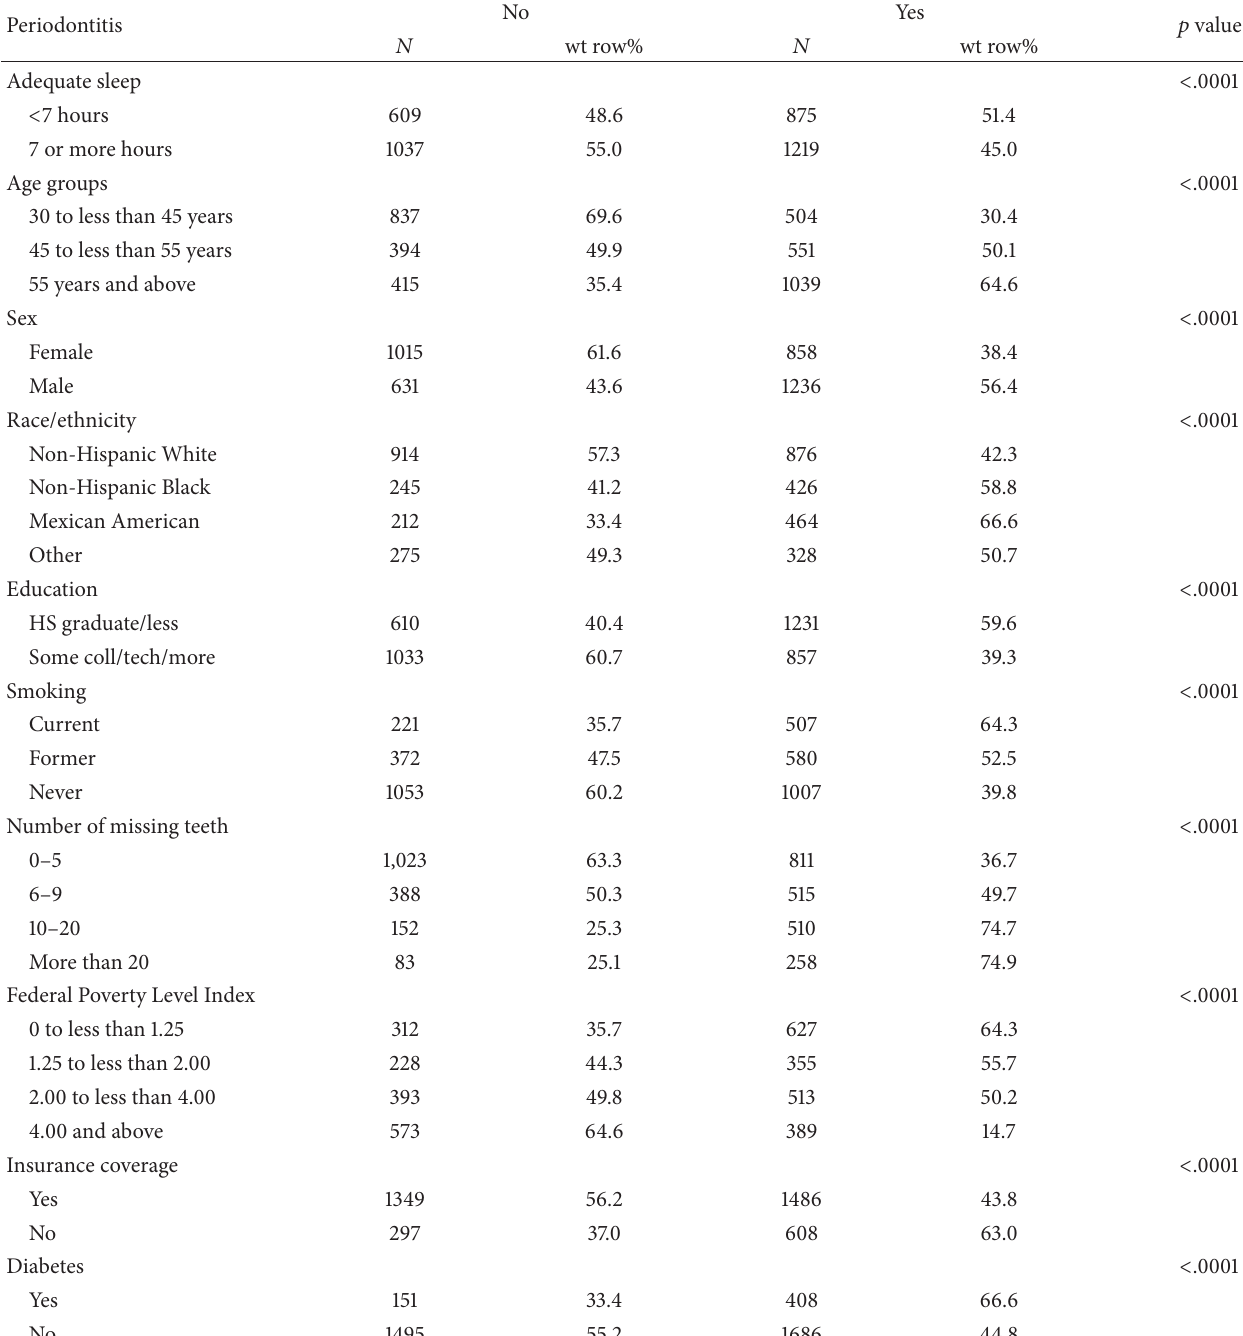
Table 2: Bivariate relationships with periodontitis, NHANES